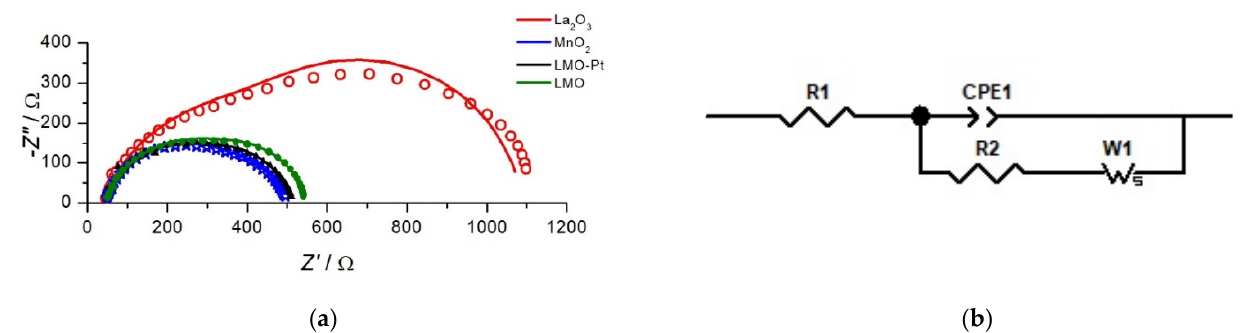
Figure 5. ( a ) Nyquist diagrams of La 2 O 3 , MnO 2 , LMO, and LMO-Pt electrocatalytic materials in O 2 -saturated 0.10 M KOH at current of − 0.15 mA with an amplitude of 0.10 mA and ( b ) equivalent circuits used to fit the experimental EIS data. Equivalent electric circuit data are presented by lines in the plots.